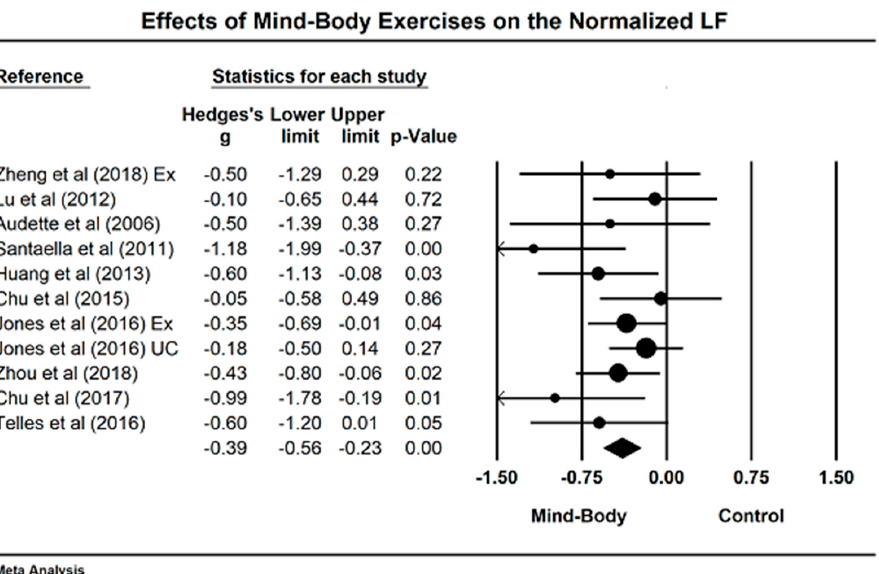
Figure 2. Funnel plot of publication bias for low-frequency power.